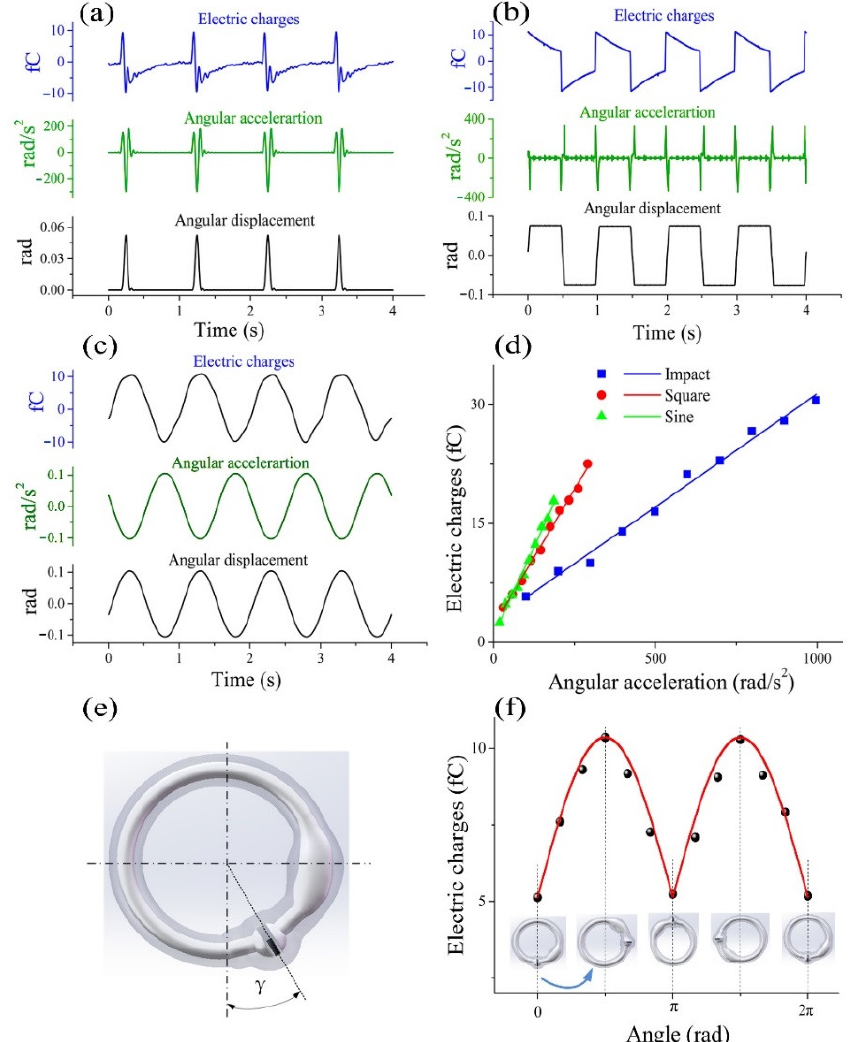
Figure 5. Experimental results for sensing angular acceleration using the 1-BSC: ( a ) the relationship between the amplitude of angular acceleration and the amplitude of output electric charges of the 1-BSC; ( b ) the 1-BSC sensed impact angular displacement; ( c ) the 1-BSC sensed square angular displacement; ( d ) the 1-BSC sensed sinusoidal angular displacement; ( e ) diagram of the angle γ ; ( f ) the relationship between the amplitude of the electric charges output by the SMPF and the angle γ.